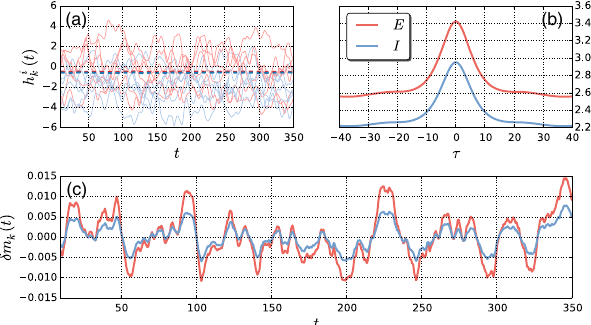
FIG. 7. Fluctuations of an E-I balanced network with linear- threshold transfer function . Same parameter set as in Fig. 6(c). (a) Traces of the local fields of six neurons from excitatory (red) and inhibitory (blue) populations. Dashed lines show mean α g , J − g , input into each population. (b) Time-lagged autocorrelation J W EE ¼ IE ¼ E ¼ II ¼ function of two populations computed from the simulation. (c) Trace of the fluctuations in the spatially averaged activities δ m t Þ ≡ m t Þ − h m t Þi of both populations [same color k ð k ð k ð t codes as (a)]. Simulations of network are similar to the one used in Fig. 6(b), with g ¼ 1 . 6